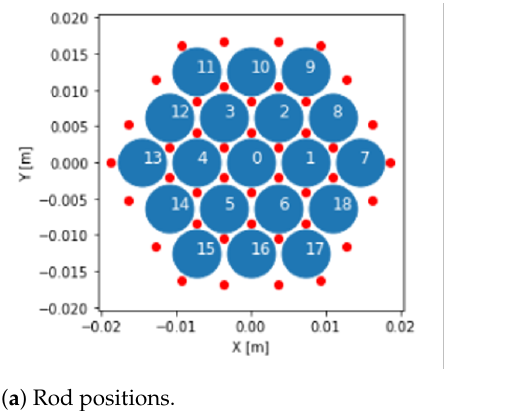
Figure 5. Rod and subchannel positions and numbering adopted for ORNL’s 19-pin benchmark. ( a ) Position and numbering of the heated rods with the subchannel center indicated with red dots. ( b ) Center position and numbering of the